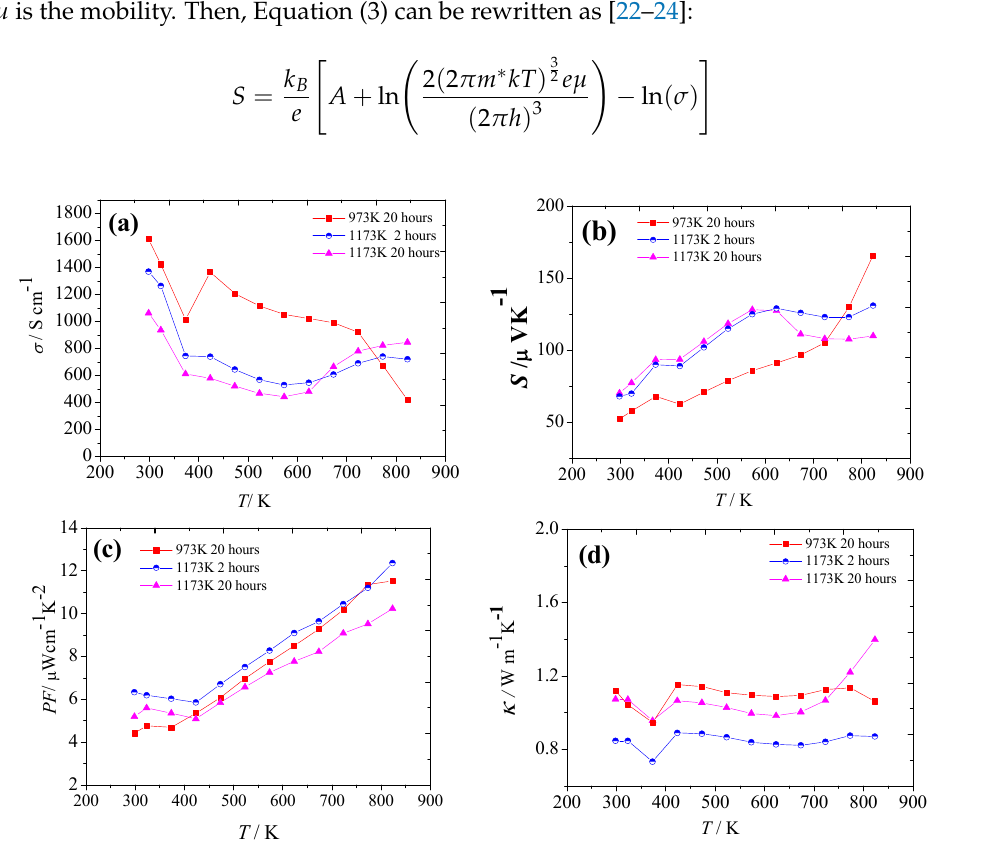
Figure 4. Thermoelectric properties (( a ) electrical conductivity, σ ; ( b ) Seebeck coefficient, S ; ( c ) power factor, PF ; and ( d ) thermal conductivity, κ ) for the Cu 2 Se samples sintered under different conditions.